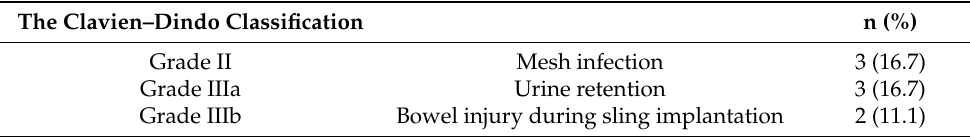
Table 4. Postoperative complications (n =